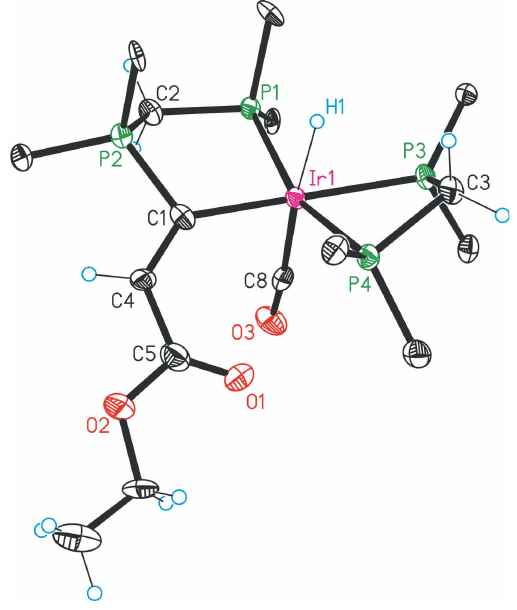
Figure 2 Structure of one of the two independent units in complex 4 with displacement ellipsoids drawn at the 30% probability level. For clarity, only the ipso carbon atoms of the phenyl groups are shown and the counter-ions and solvent molecules are omitted.